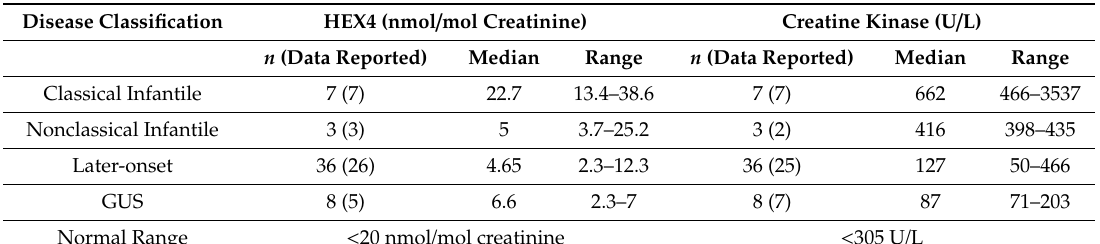
Table 3. Confirmatory Test Results for Patients with Pompe Disease or Genotypes of Unknown Significance